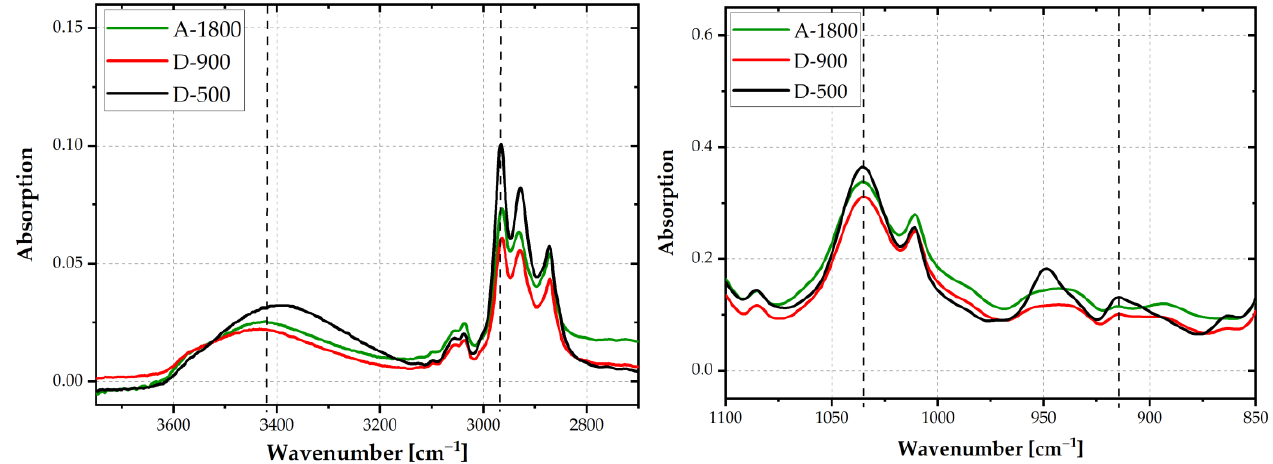
Figure 4. FTIR-ATR spectra in the range from 3700 to 2700 cm − 1 ( left ) and 1100 to 850 cm − 1 ( right ) of epoxies with average EEW values of 500, 900, and 1800 g/mol.